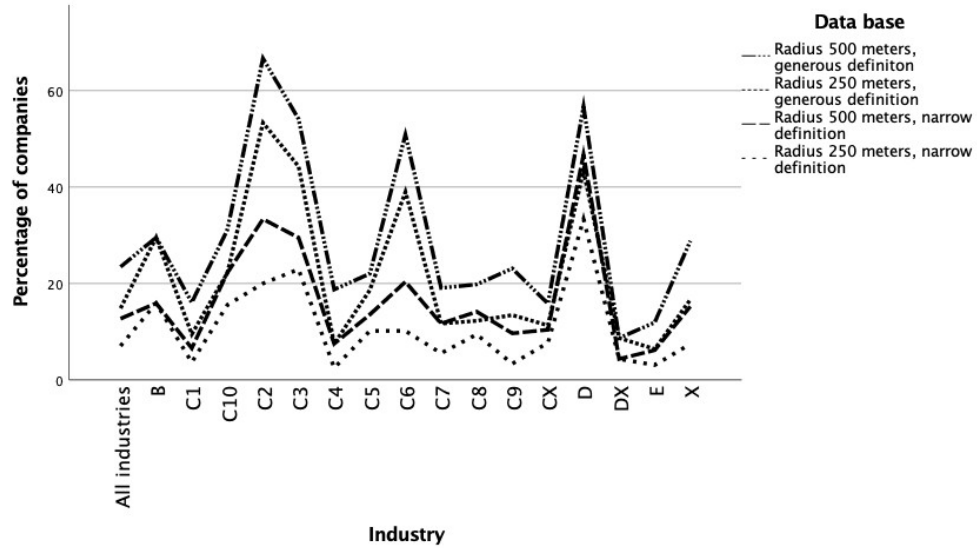
Figure 11. Track connections: comparison of different parameters of radius analysis.